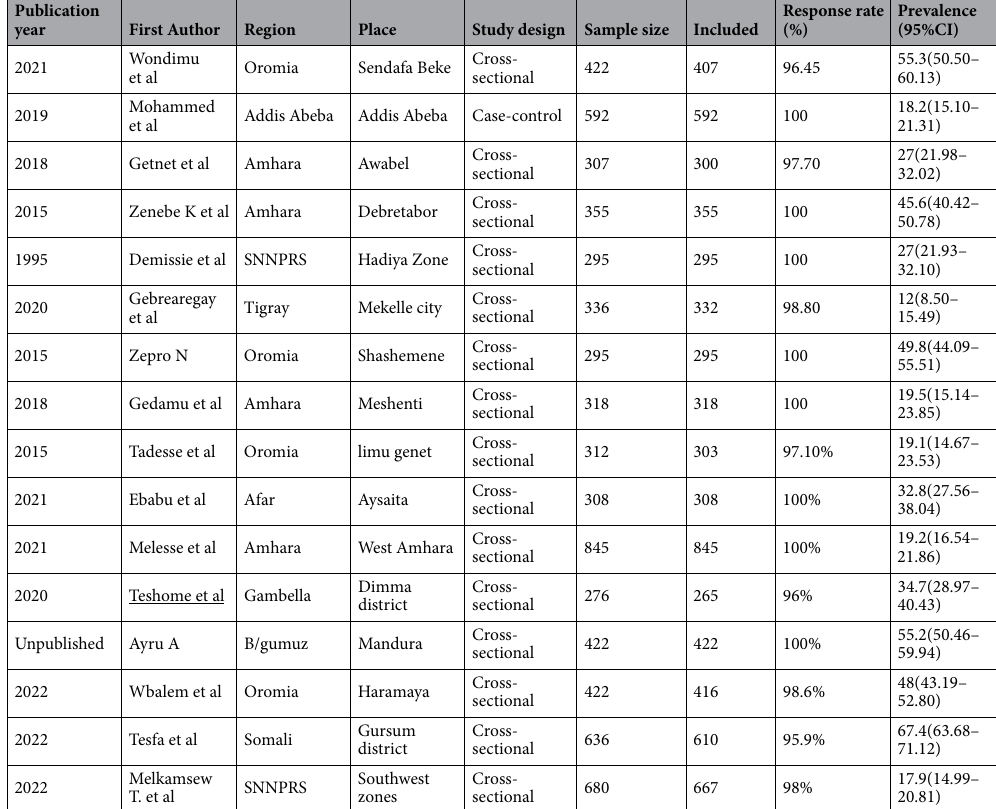
Table 1. Summary of included studies on the prevalence of food taboo practices among pregnant women in